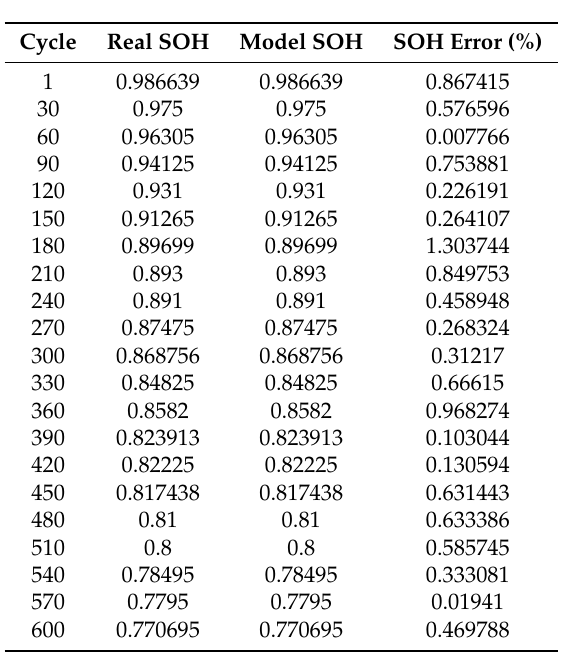
Table 5. Numerical results for comparison between the linear regression model based on the IC curve peak point of cell no.1 and a real SOH for the IC curve peak point of a retired cell (SOH error = Real SOH − Model SOH).